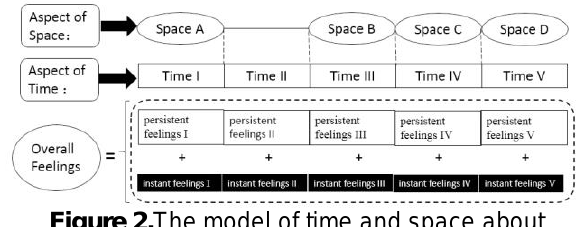
Figure 2. The model of time and space about people’s sense of the experience With speeding up the sequence of space, the continuity of spatial sequence strengthened gradually. The distant view is relatively stable and the nearby view is